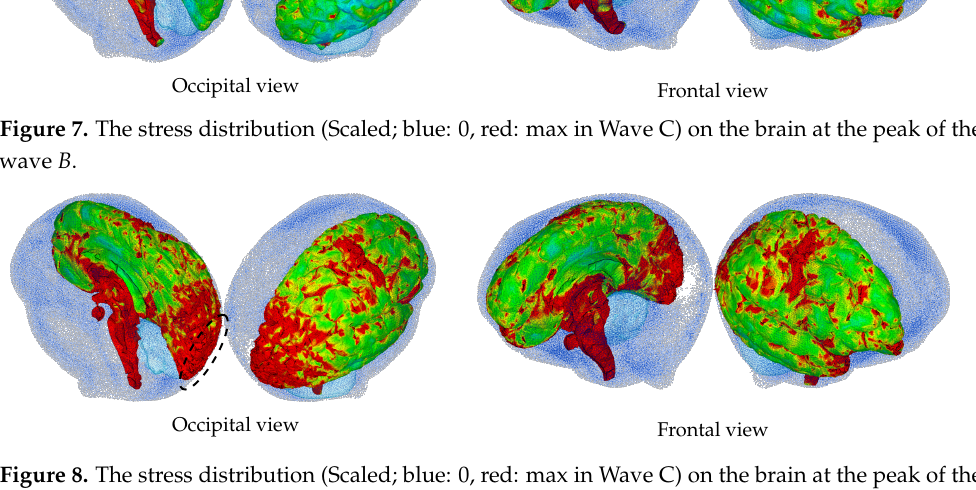
Figure 8. The stress distribution (Scaled; blue: 0, red: max in Wave C) on the brain at the peak of the wave C . Compared to waves A and B , no fluid particles are observed in the occipital lobe (dashed circle). Hence, direct brain-to-skull can be assumed in that area.